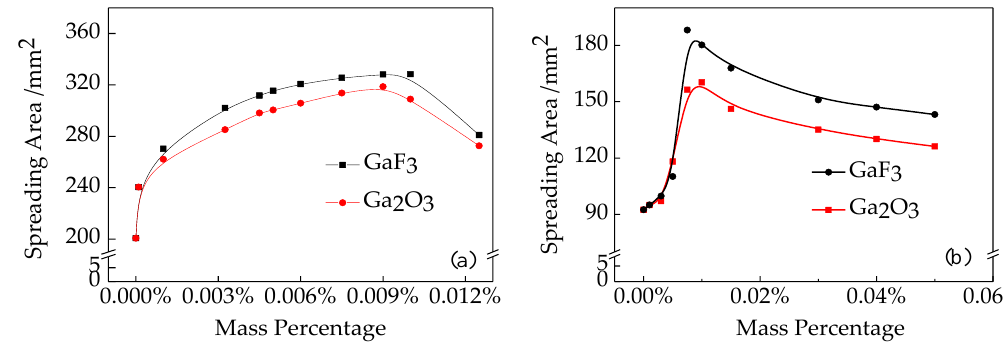
Figure 2. Spreading area of Zn-15Al filler metal ( a ) 6061 aluminum alloy; ( b ) Q235 low-carbon steel.